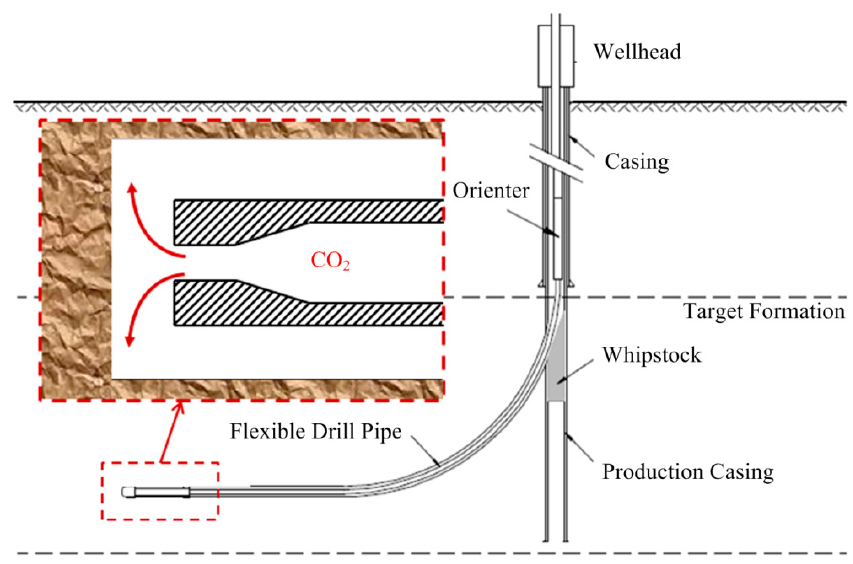
Figure 1. Schematic picture of the application of SC-CO 2 in the exploitation of shale gas.